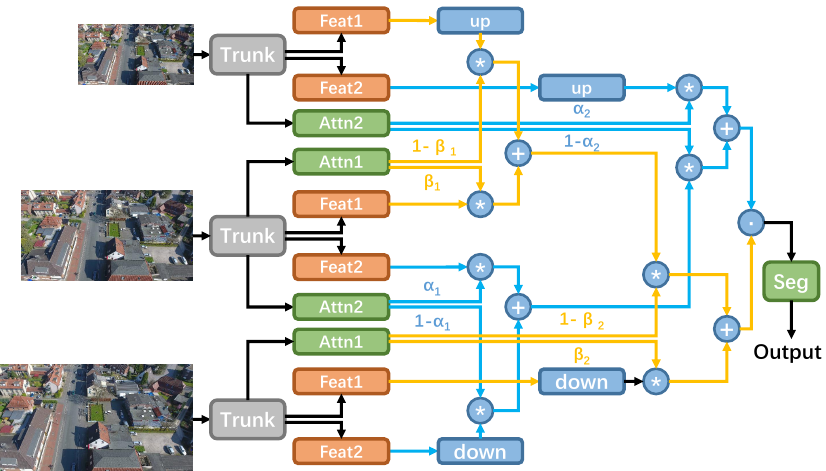
Figure 5. Architecture of the bidirectional multi-scale attention networks. The structure is the combination of two feature level hierarchical multi-scale attention nets corresponding to two pathways, where they share the same trunks. The coarse to fine pathway and the fine to coarse pathway are marked with the yellow and the blue arrows, respectively. ⊕ , (cid:126) stand for element-wise addition and multiplication, respectively. (cid:12) stands for concatenation in channel